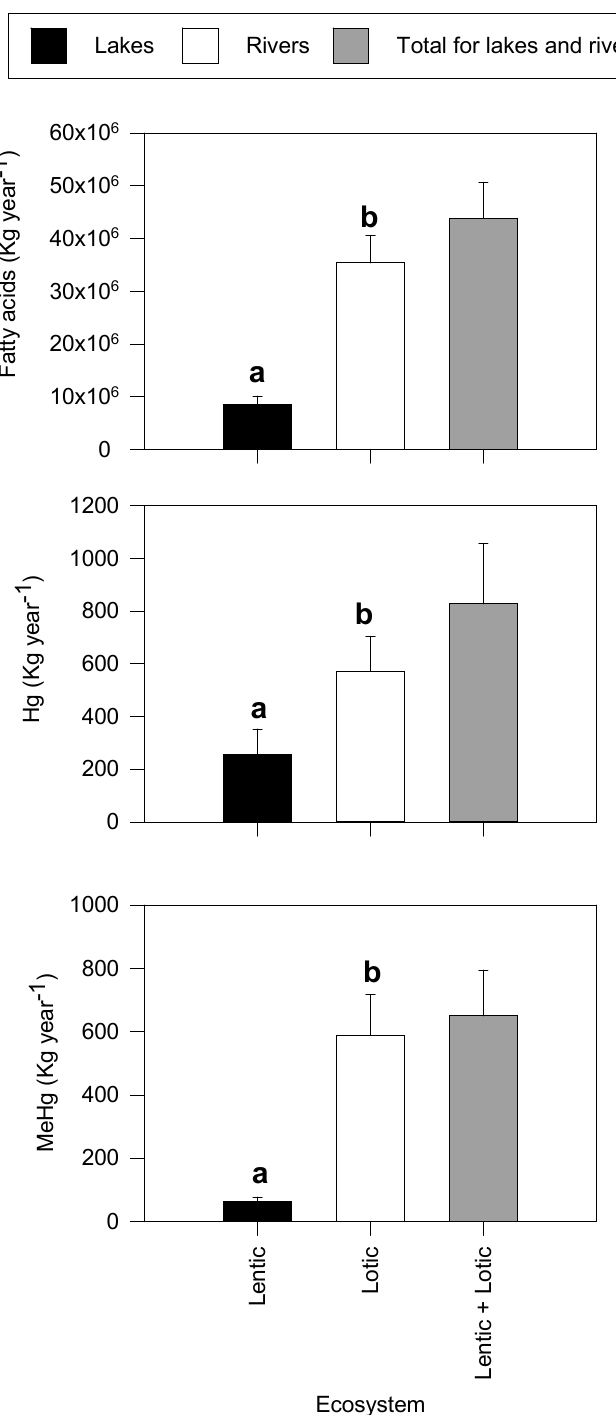
Figure 4. Global estimate (± SD) of physiologically important fatty acids, methylmercury (MeHg) and total mercury (Hg) calculated from diverse ecosystems. The letters depict results from Medcalc ® comparison of means calculator between lentic and lotic systems, where values with the same letters depict no significant difference between the export values.